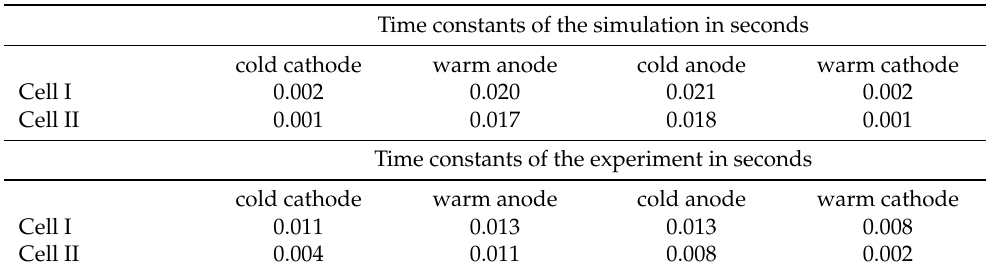
Table 4. Comparison of measured and simulated relaxation times (all given in seconds) of both electrodes of both